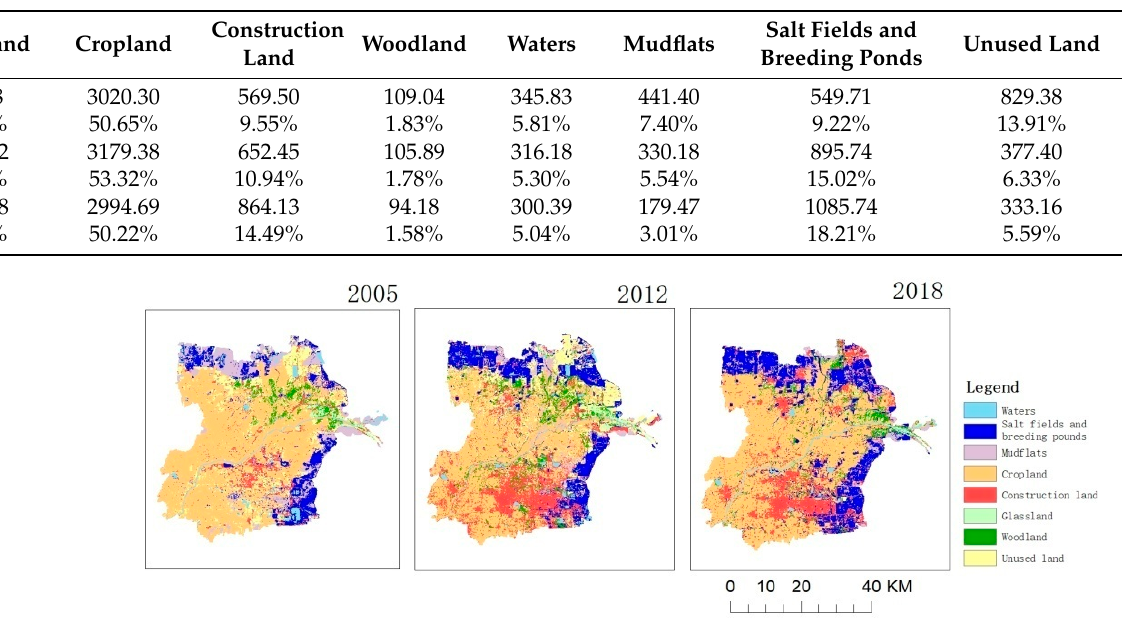
Figure 2. Distribution map of the landscape types.